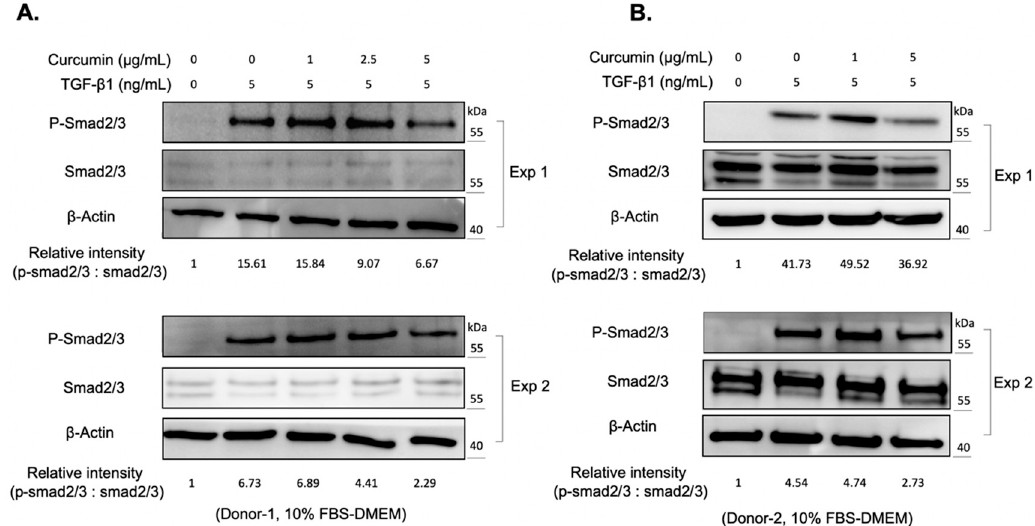
Figure 3. Curcumin attenuates the TGF- β 1 signaling in orbital fibroblasts. ( A ) Western blots showed the expression of phosphorylated Smad 2/3 (p-Smad 2/3) and total Smad proteins (Smad 2/3) at indicated conditions of the orbital fibroblasts from Donor-1. The relative intensity of phosphorylated Smad 2/3 quantified using the Image J software. Exp 1: experiment 1; Exp 2: experiment 2. ( B ) Western blots showed the expression levels of phosphorylated Smad 2/3 (p-Smad 2/3) and total Smad proteins (Smad 2/3) at indicated conditions of the orbital fibroblasts from Donor-2. The relative intensity of phosphorylated Smad 2/3 quantified using the Image J software. Exp 1: experiment 1; Exp 2: experiment 2.